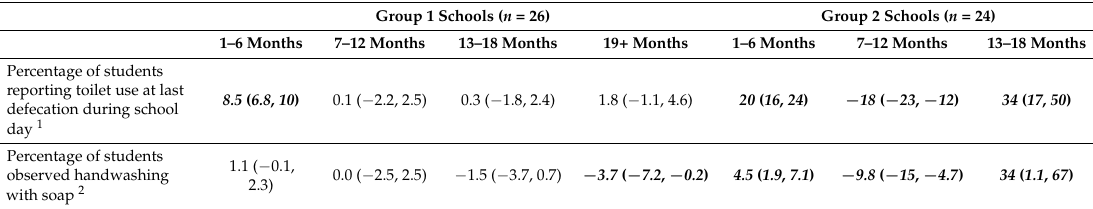
Table 4. Per month change in achievement project outcomes among intervention schools by time since project